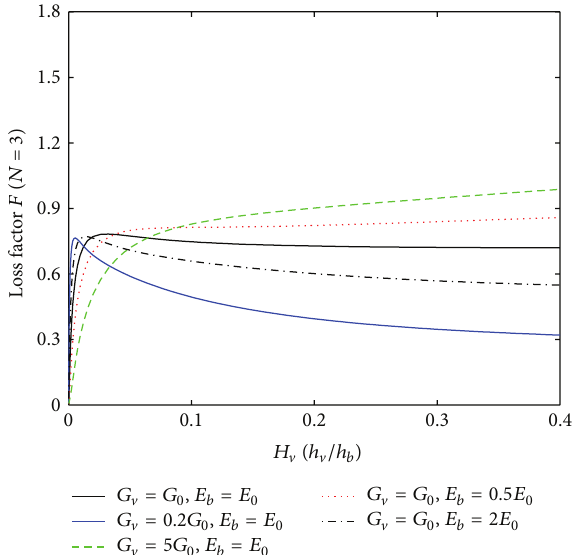
Figure 13: Efficiency curves for CLD beams with various material properties ( 𝐻 𝑏 = 𝐻 𝑐 = 0.012 ).